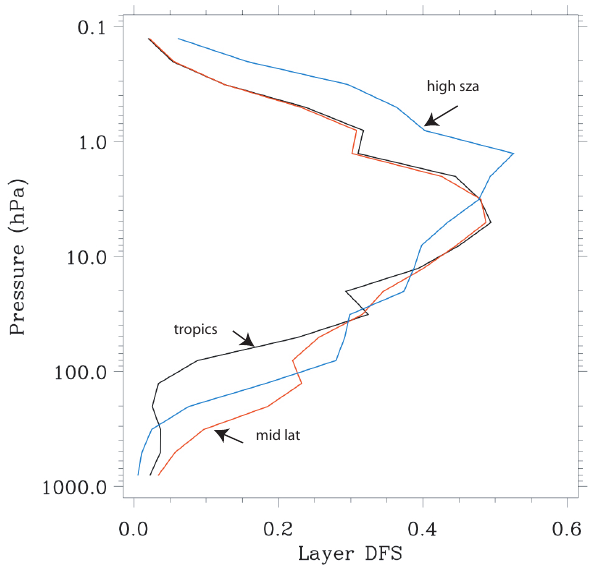
Fig. 8. Variation of layer DFS (LDFS) with height. LDFS provides the fraction of ozone change in a layer that would appear in the same layer in the retrieved profile. The vertical resolution of the retrieved profile is ∼ 3.2/LDFS in km, showing that the vertical resolution varies from ∼ 6km near 3hPa to ∼ 15km in the lower stratosphere. Lower stratospheric LDFS is largely determined by tropopause height, and the mesospheric LDFS by SZA.